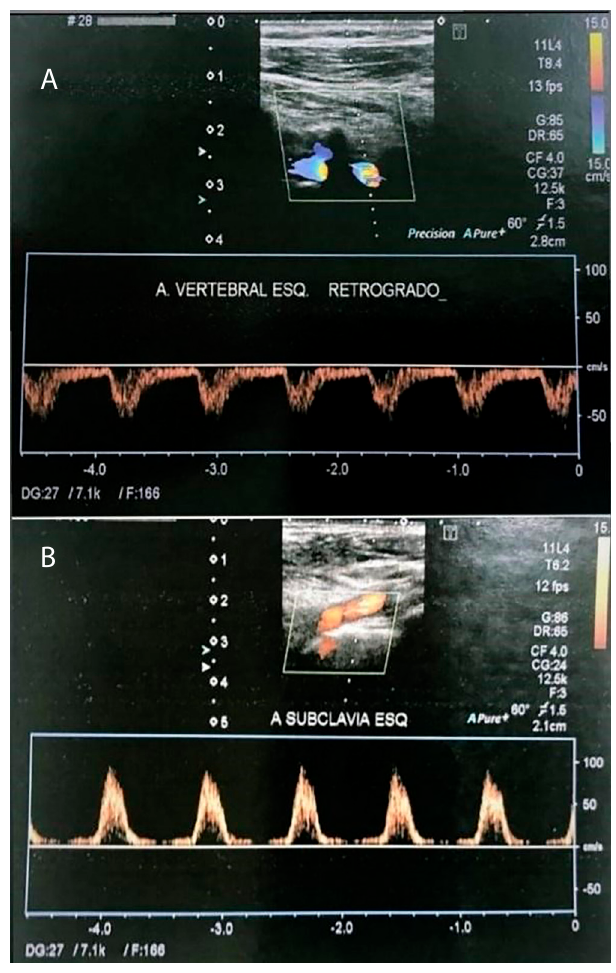
Fig. 2 – (A) Doppler ultrasonography of the left vertebral artery showing retrograde flow. (B) Doppler ultrasonography of the LSA revealing proximal occlusion and distal flow with a postobstructive biphasic spectral